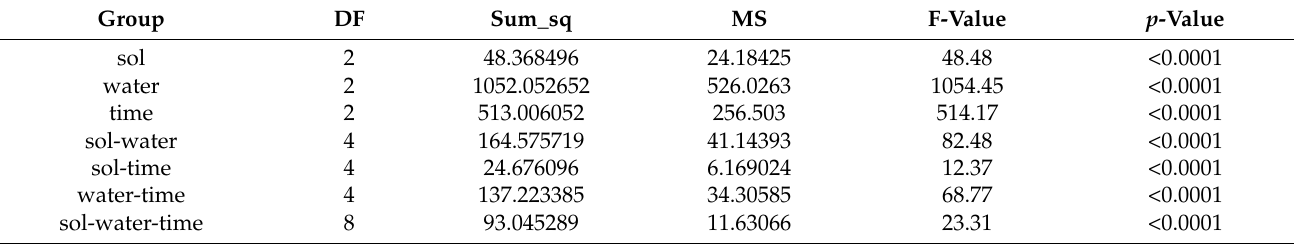
Table 2. The independence or interactive effects of deep eutectic solvents (sol), water contents (wa- ter), and ultrasound extraction times (time) on tea polysaccharides yield were analyzed based on analysis of variance (ANOVA) results.